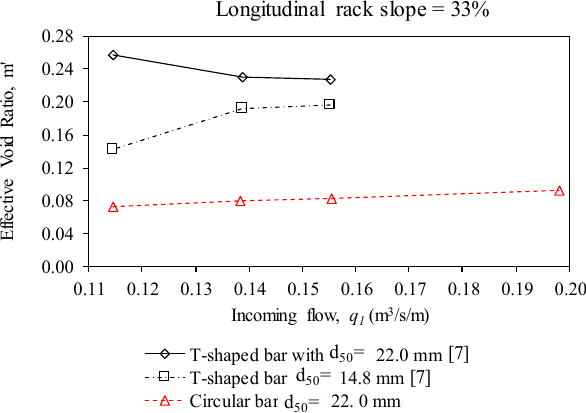
Figure 17. Comparison of effective void ratio, m ′ , for circular bars and values previously presented for T-shaped bars [7]. All cases have a void ratio of m = 0.28.